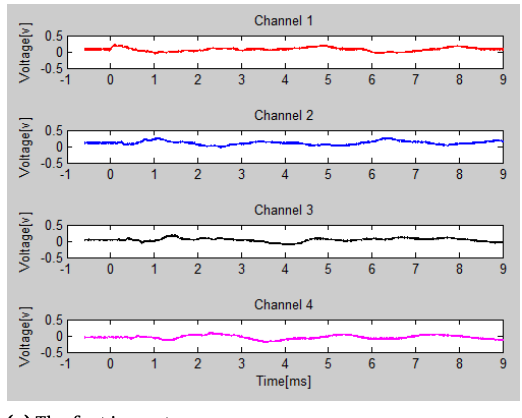
Figure 3: Impact test devices and the data acquisition devices